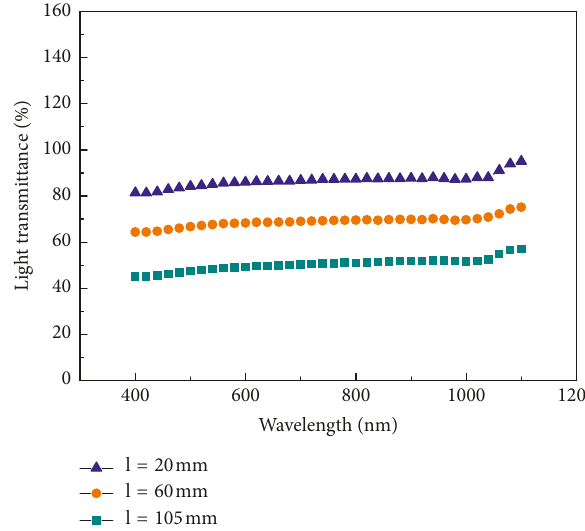
Figure 18: Relationship between the wavelength and light trans- mittance of specimens with different lengths.